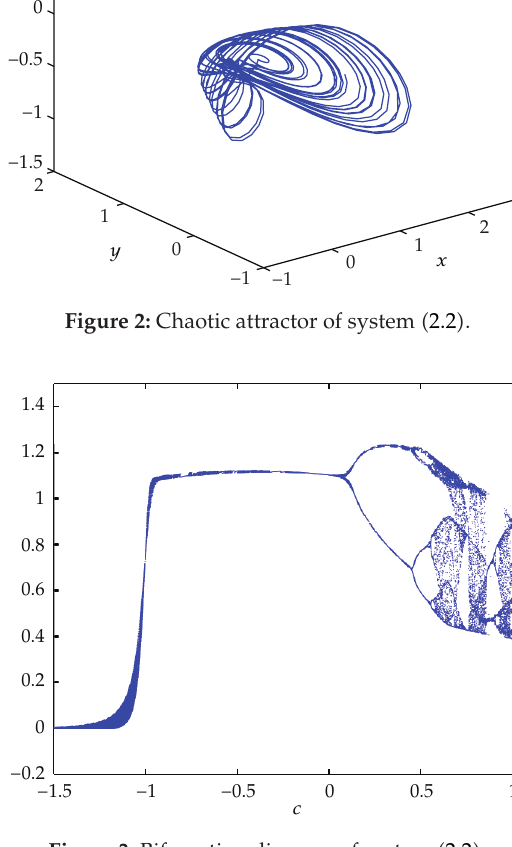
Figure 3: Bifurcation diagram of system (cid:5) 2.2 (cid:6) .